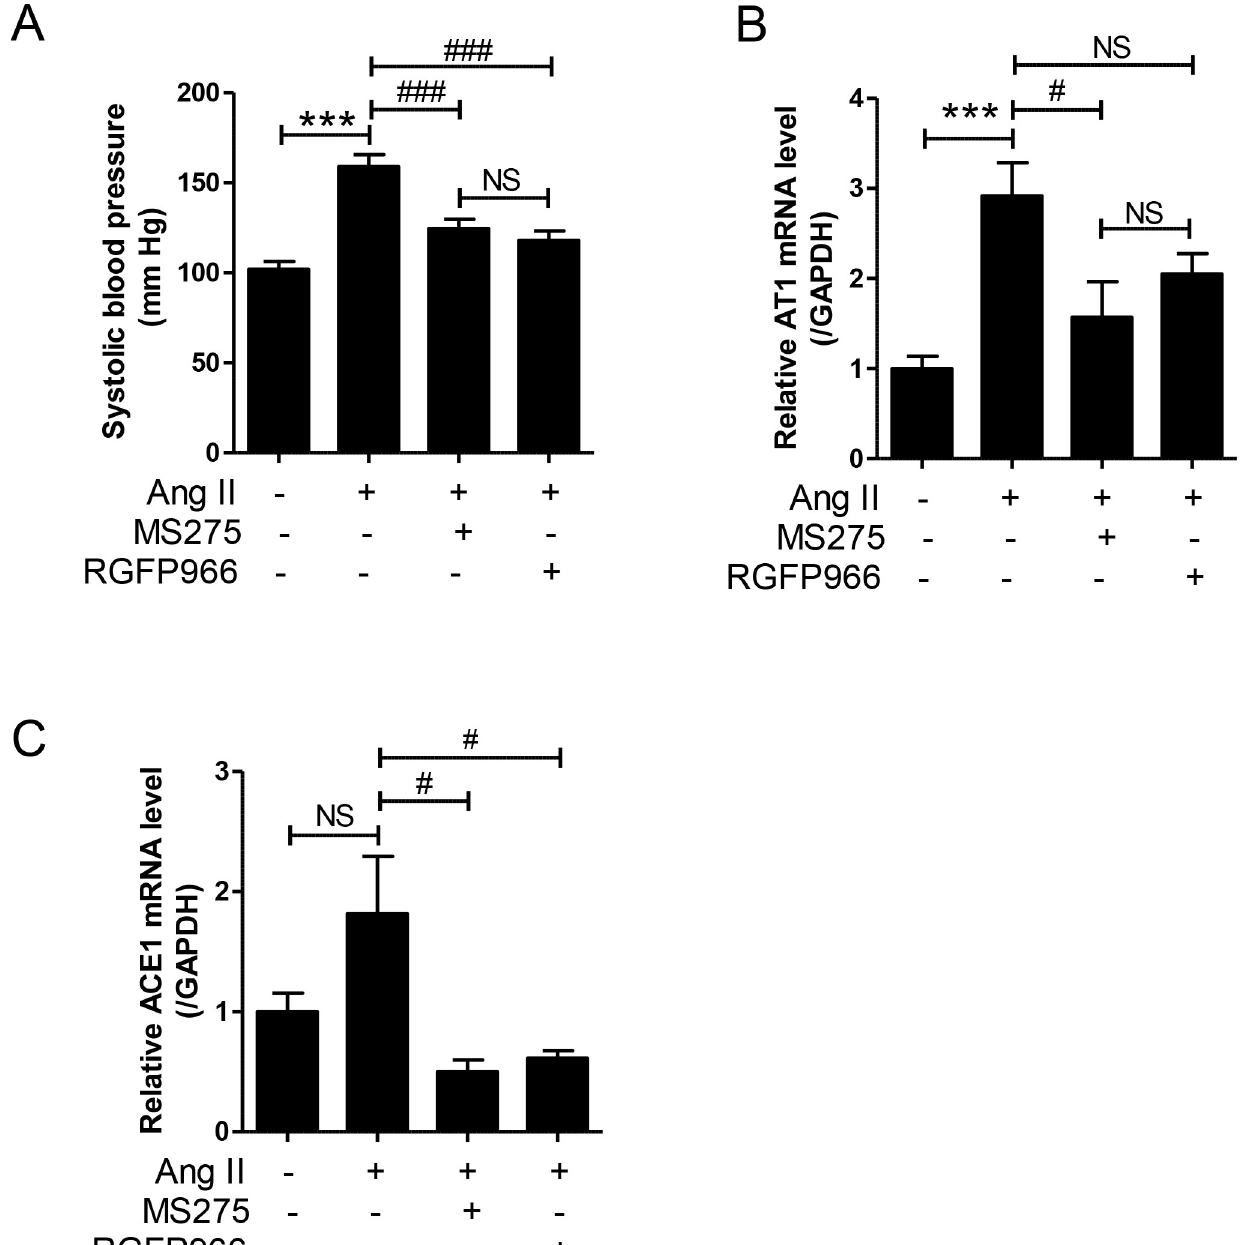
Fig 1. MS-275 and RGFP966 reduced systolic blood pressure in angiotensin II-induced hypertensive mice by downregulating AT1 and angiotensin- converting enzyme 1 (ACE1) expression. (A) After angiotensin II infusion (1.3 mg � kg -1 � day -1 ) to mice for 1 week, we injected MS-275 or RGFP966 (both 3 mg � kg -1 � day -1 ) daily to mice for additional 7 days. Systolic blood pressures were measured in awake mice. (B and C) Transcript levels of aortic AT1 and ACE1 were quantified using quantitative real-time reverse transcription-polymerase chain reaction (qRT-PCR). GAPDH was used to normalize the values. Data are presented as the means ± SE (n = 8 per group). ��� p < 0.001 versus sham group; # p < 0.05 and ### p < 0.001 versus angiotensin II group; NS, not